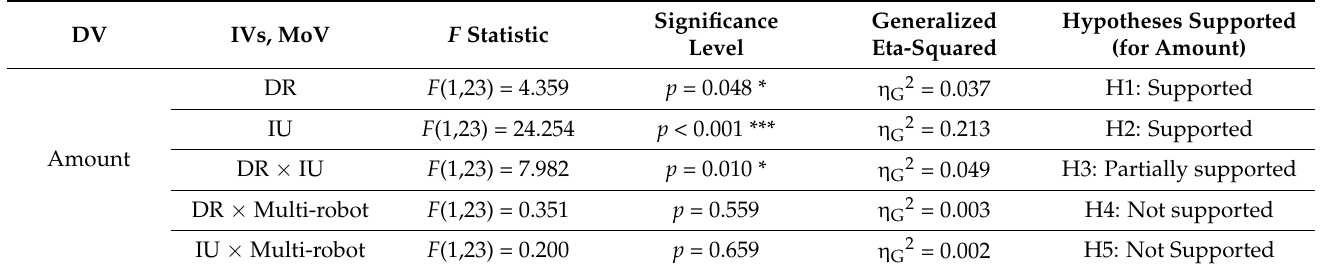
Table 6. ANOVA results on amount.